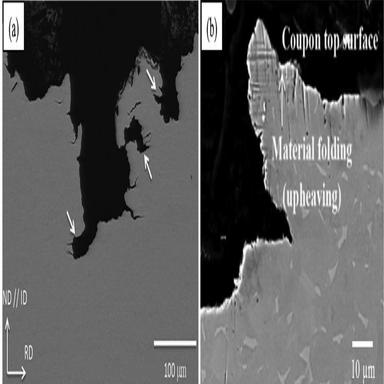
(a): Cross-section of Ti-6Al-4V in advanced stages of WDE with 600 µm droplets at 350 ms−1 impact velocity; (b) Cross-section of WDE-tested Ti-6Al-4V showing material folding.